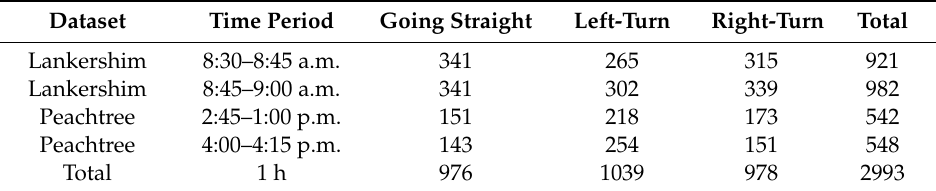
Table 1. Summary statistics.